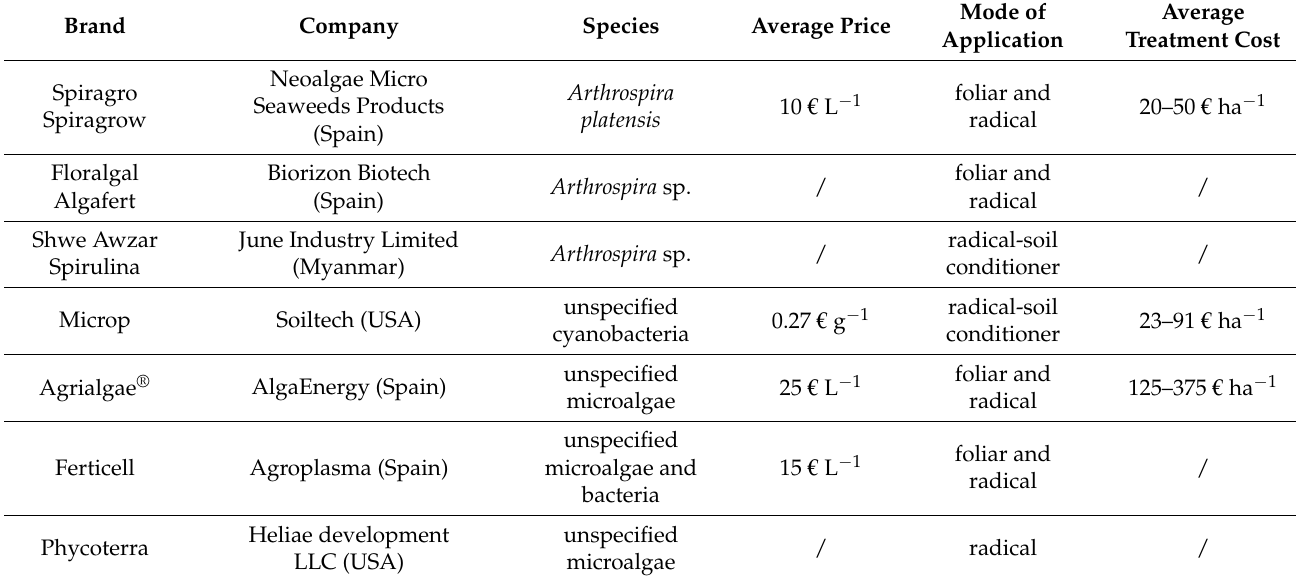
Table 2. Cyanobacterial biostimulants currently on the market. Products claimed as microalgae-based have been included in the survey when the species used were not indicated in the product information as the term microalgae often includes cyanobacteria. To distinguish biostimulants from fertilizers, only products whose benefits are attributed to the content of phytohormones, free amino acids, and other bioactive molecules were considered. The average treatment costs were calculated on the basis of the doses recommended on the label for horticultural and fruit crops and without considering the costs necessary for equipment and labor required to perform the